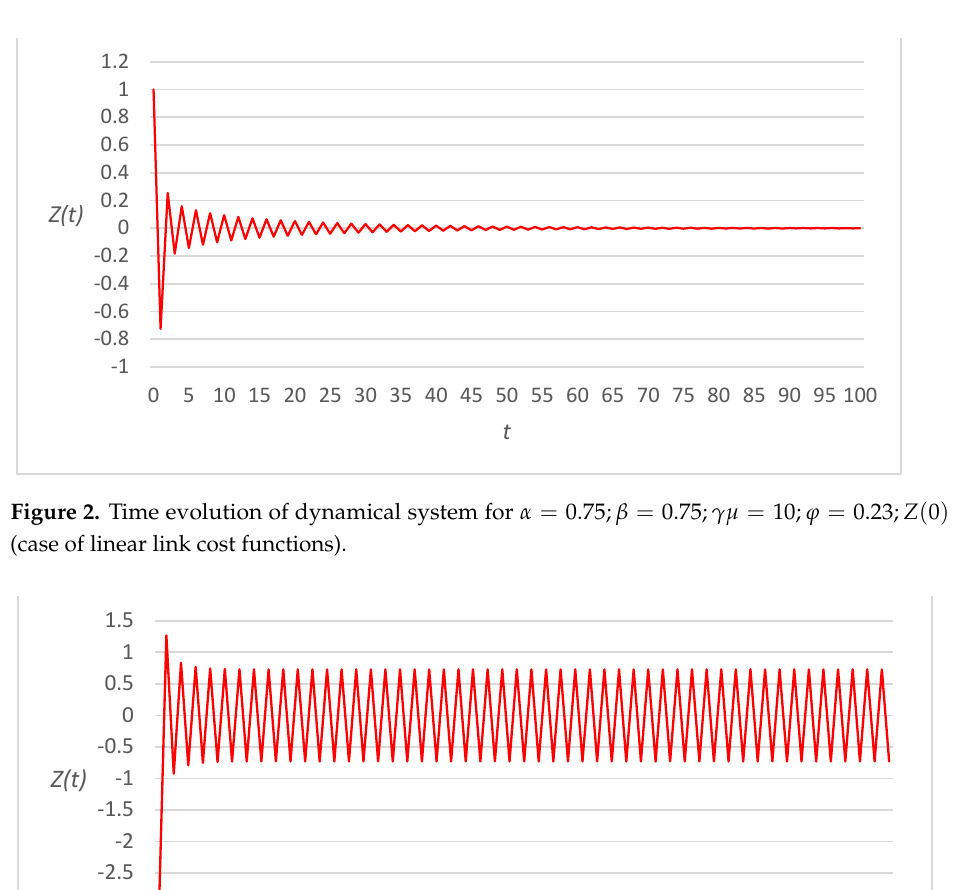
Figure 1. Time evolution of dynamical system for 𝛼 = 0.1; 𝛽 = 0.1; 𝛾𝜇 = 2.5; 𝜑 = 0.6; 𝑍(0) = 5 (case of linear link cost functions).